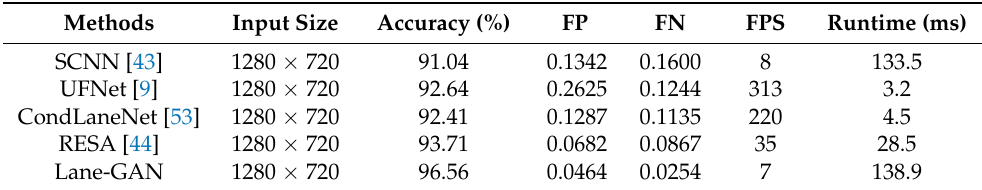
Table 1. The comparison results between the proposed method and the state-of-the-art methods on the constructed dataset.